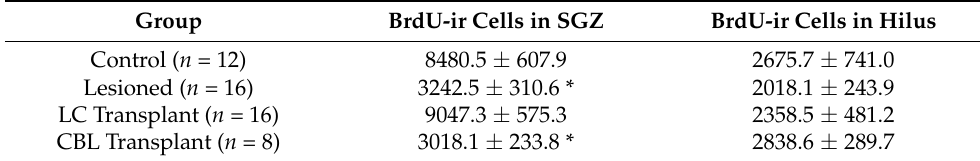
Table 3. BrdU-immunoreactive cell